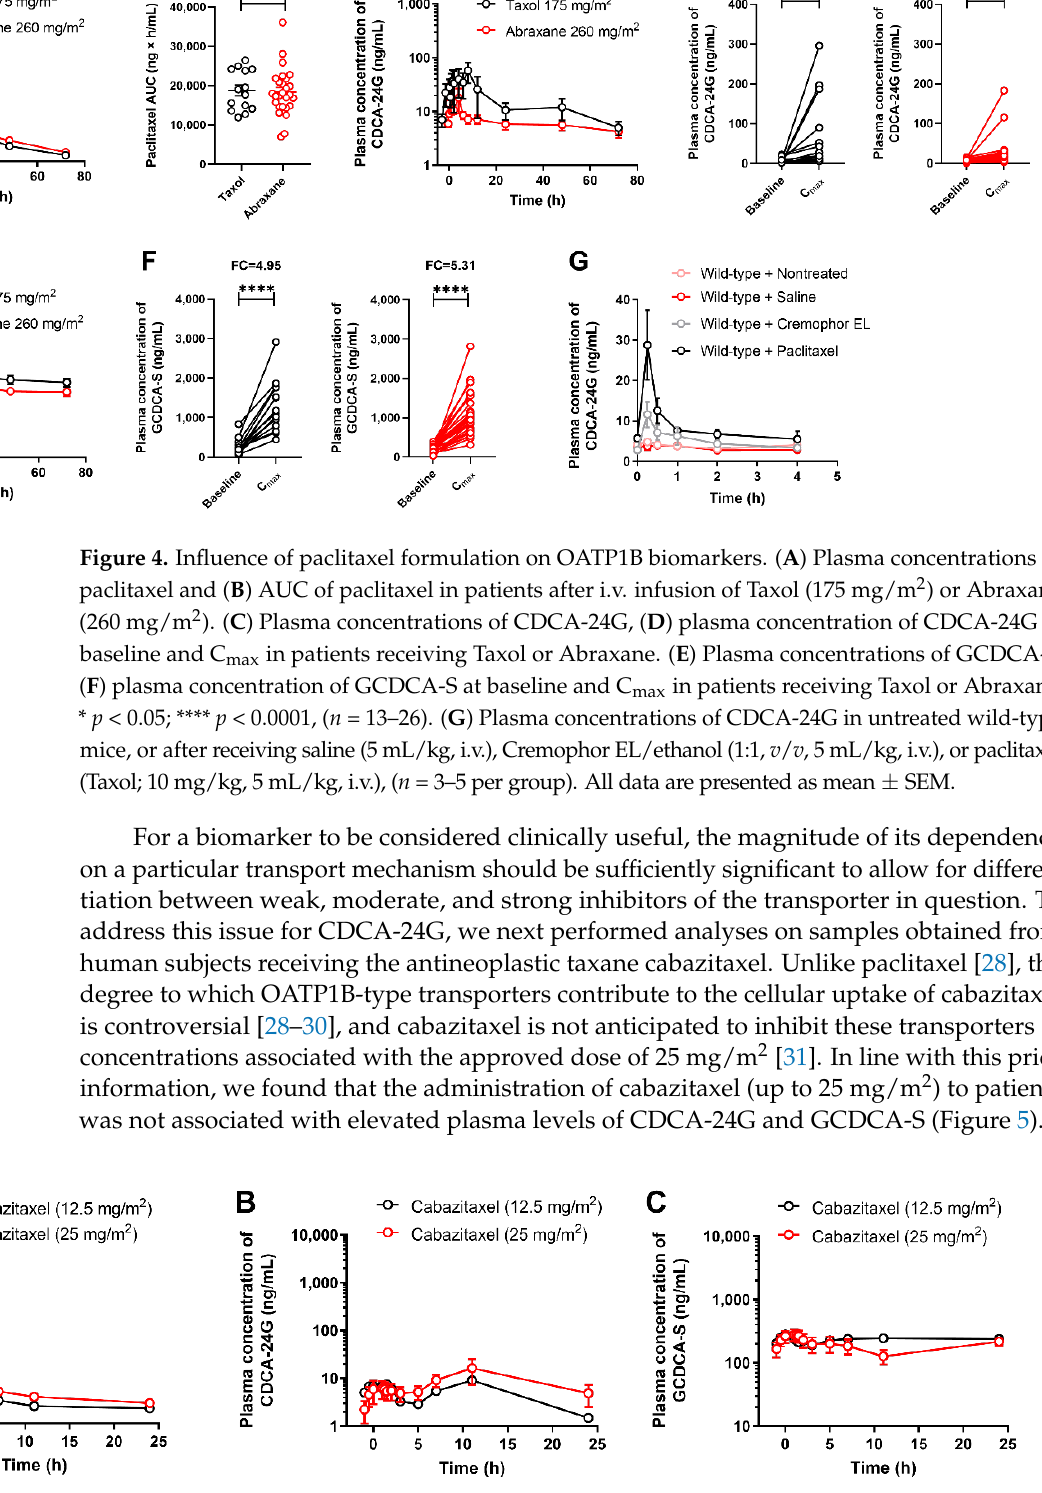
Figure 5. Influence of cabazitaxel on OATP1B biomarkers. Plasma concentrations of ( A ) cabazitaxel, ( B ) CDCA-24G, and ( C ) GCDCA-S in patients after i.v. infusion of cabazitaxel at doses of 12.5 or 25 mg/m 2 ( n = up to 10 per dose level). All data are presented as mean ± SEM.